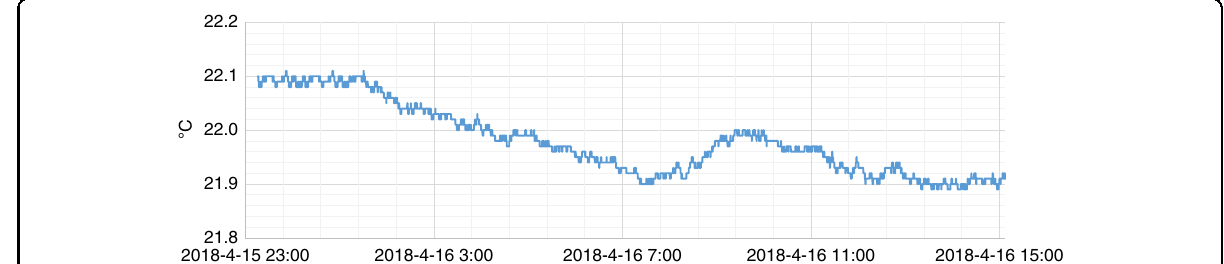
Fig. 2 Temperature variations during the measurement over 12 h. Testing environment temperature is maintained at about 22 ℃ with no more than 0.2 ℃ fl